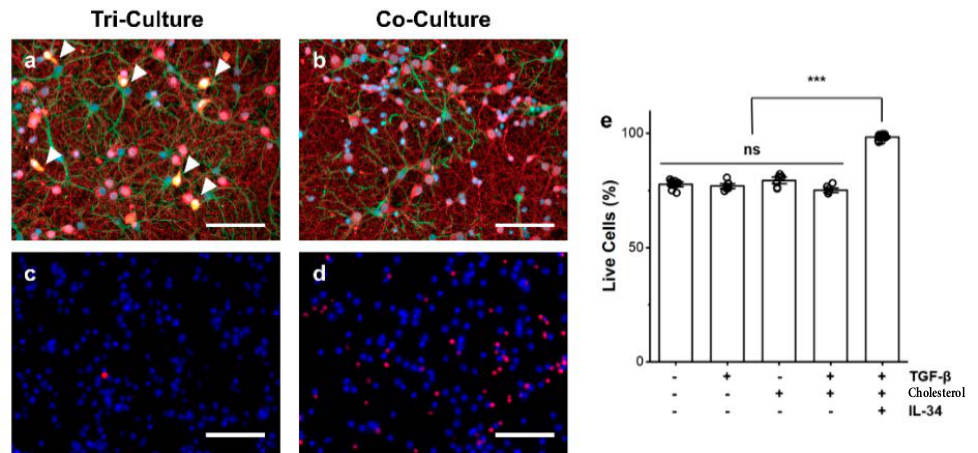
Figure 1. Representative fluorescence images of the ( a ) tri-culture and ( b ) co-culture at DIV 9 demonstrating the presence of microglia in the tri-culture. The cultures were immunostained for the three cell types of interest: neurons—anti- β III-tubulin (red), astrocytes—anti-GFAP (green), microglia—anti-Iba1 (orange), general nuclear stain DAPI (blue). As expected, microglia are only present in the tri-culture (highlighted with arrows). Representative images of ( c ) tri-cultures and ( d ) co- cultures stained with Hoechst 33342 (Live, blue) and propidium iodide (Dead, red). ( e ) Comparison of the influence of TGF- β and increased cholesterol concentration on cell death in the absence of microglia as compared to the co-culture and tri-culture (containing all three additional factors). Data presented as mean ± SEM (n = 4–8 wells from two independent dissections) with individual data points plotted, *** p < 0.001 (as determined by post hoc Tukey’s test). Scale bar = 100 µm.